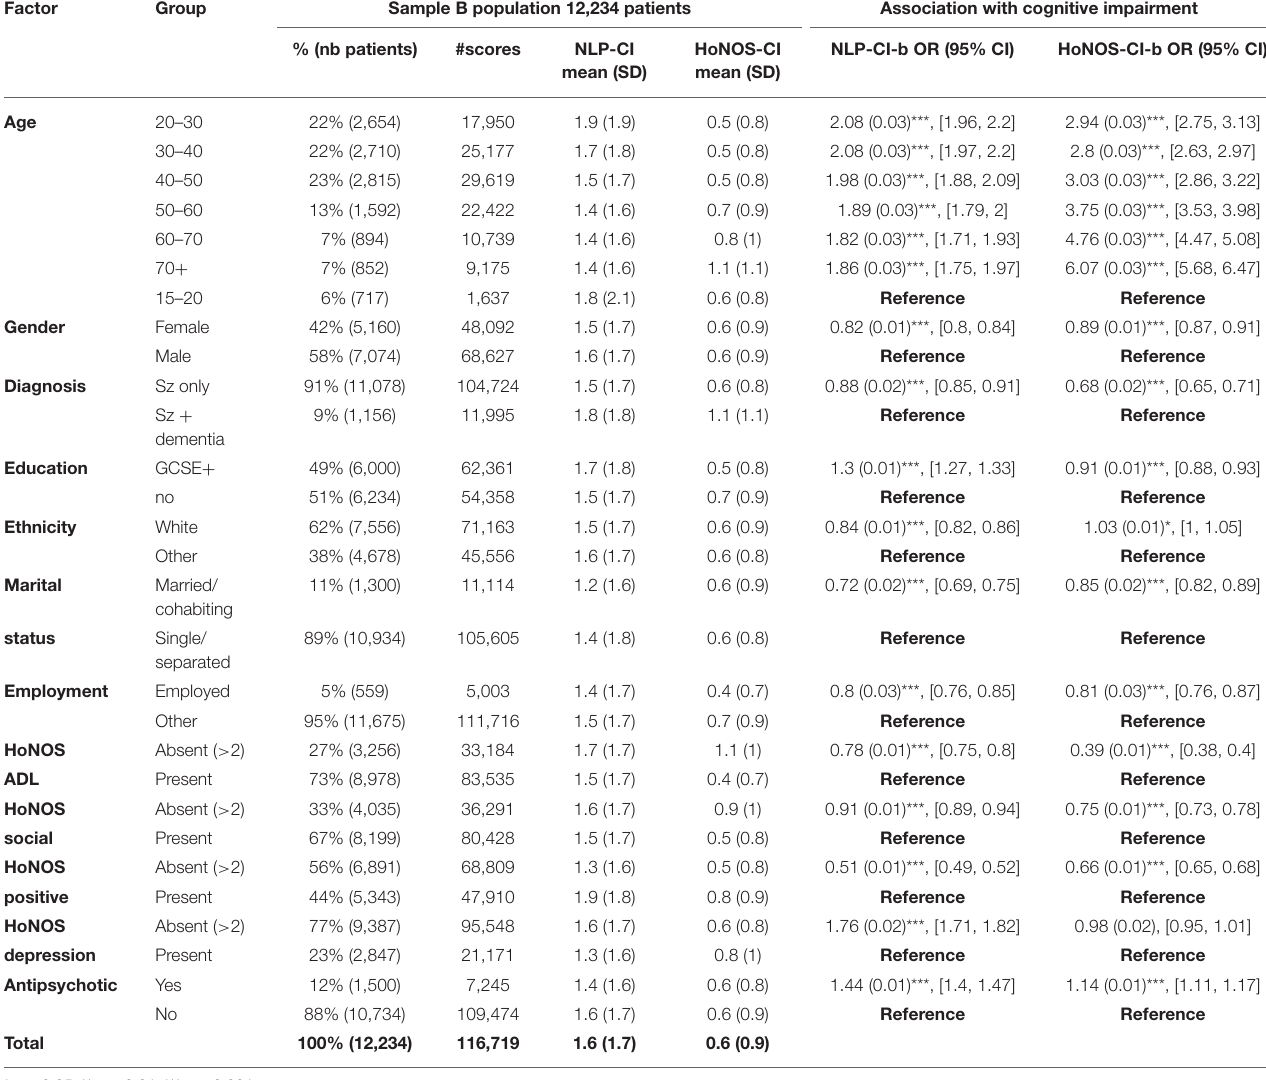
TABLE 3 | Analysis of factors associated with cognitive impairments in Sz (Sample B). Factor